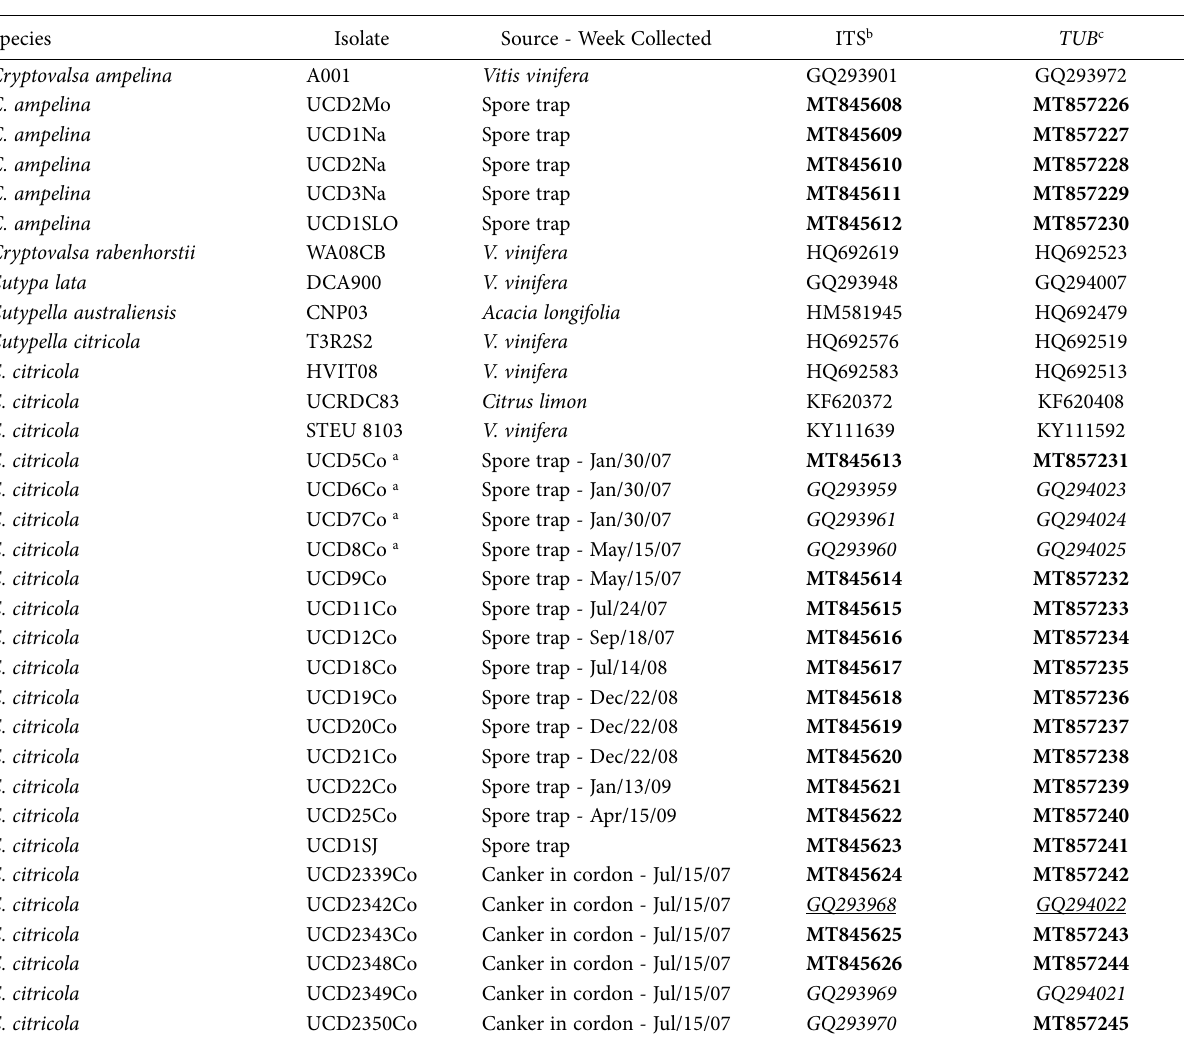
Table 1. Diatrypaceae isolates from spore traps and cankers identified in this study, and isolates retrieved from GenBank included in phylo- genetic analyses. Isolate Source - Week Collected ITS